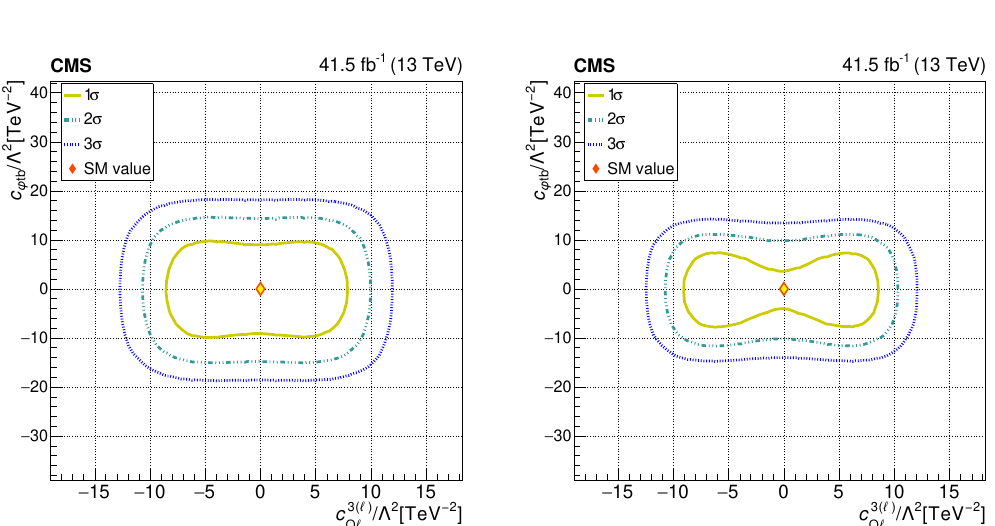
and c 3( ‘ ) with ϕ tb Q‘